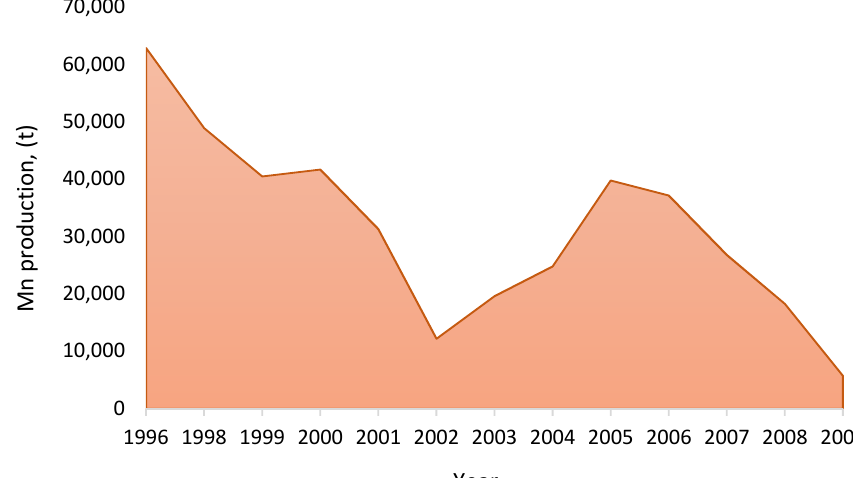
Figure 5. Historical production of Manganese in Chile (data from Cochilco [67]).